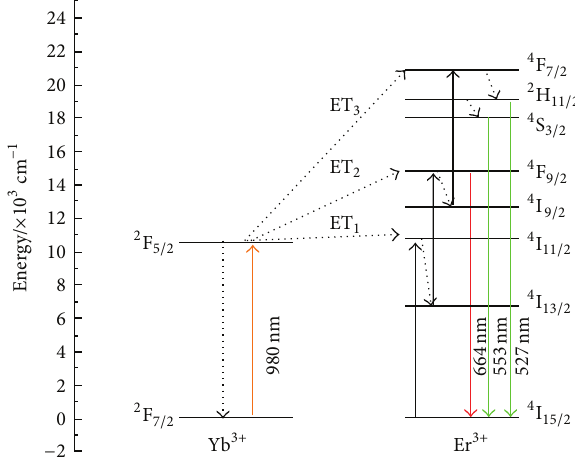
Figure 5: Energy level diagram of Er 3+ and Yb 3+ ions and the proposed UC luminescence mechanisms in BaLa 2 ZnO 5 :Er 3+ /Yb 3+ .